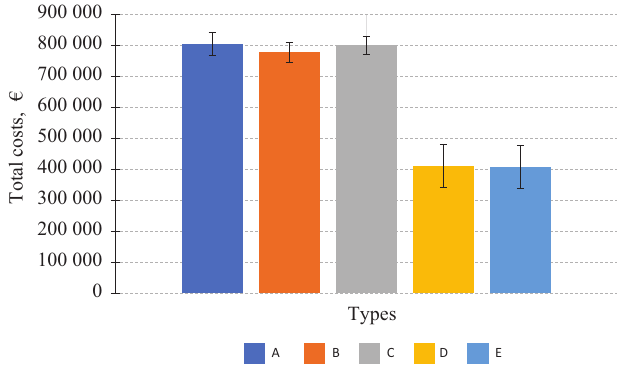
Figure 5. 95% confidence interval costs are within these limits